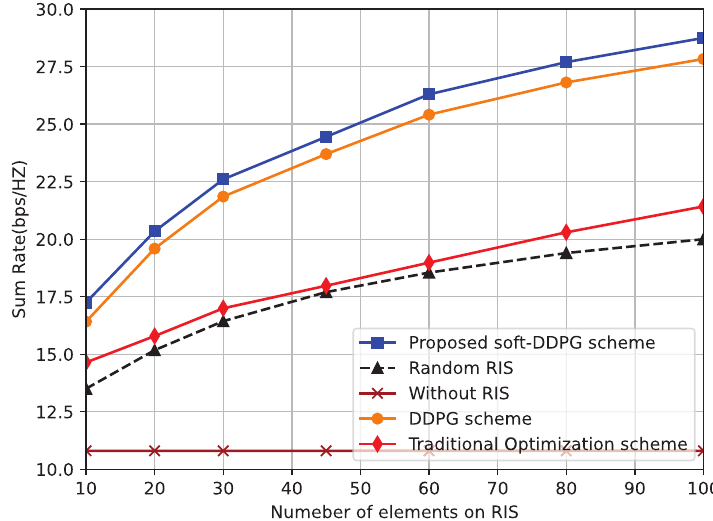
Figure 3. Sum rate performance relative to the increasing number of elements on RIS.